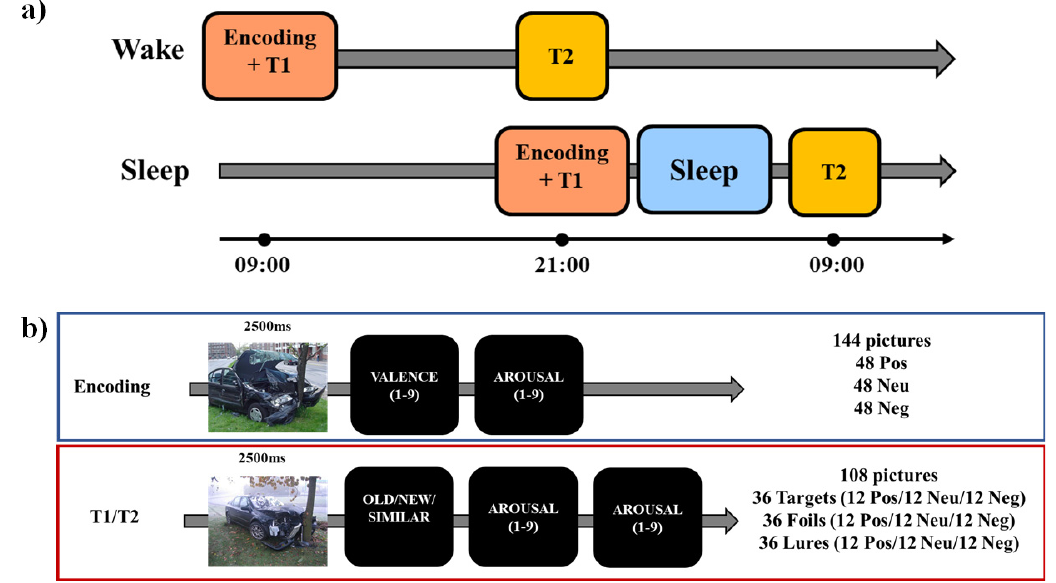
Figure 1. Schematic representation of ( a ) the experimental protocol and ( b ) the emotional mnemonic similarity task. Neg: Negative; Neu: Neutral; Pos: Positive. T1: immediate test. T2: delayed test (12-h later).